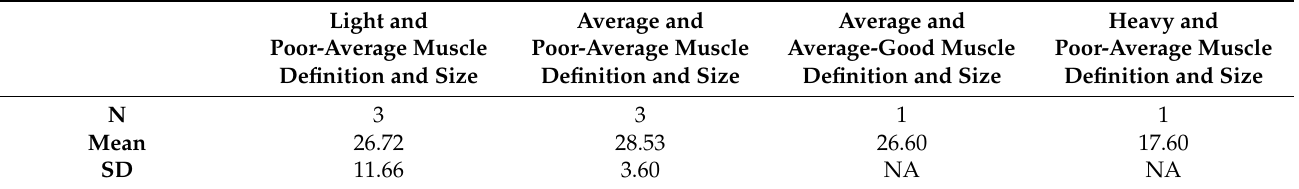
Table A1. Table demonstrating the fat percentage in individuals with different body sizes, and their muscle definition and size. Poor–average muscle definition and size = a score of 1 or 2; average–good muscle definition and size = a score of 3 or 4. NA = not applicable; SD = standard